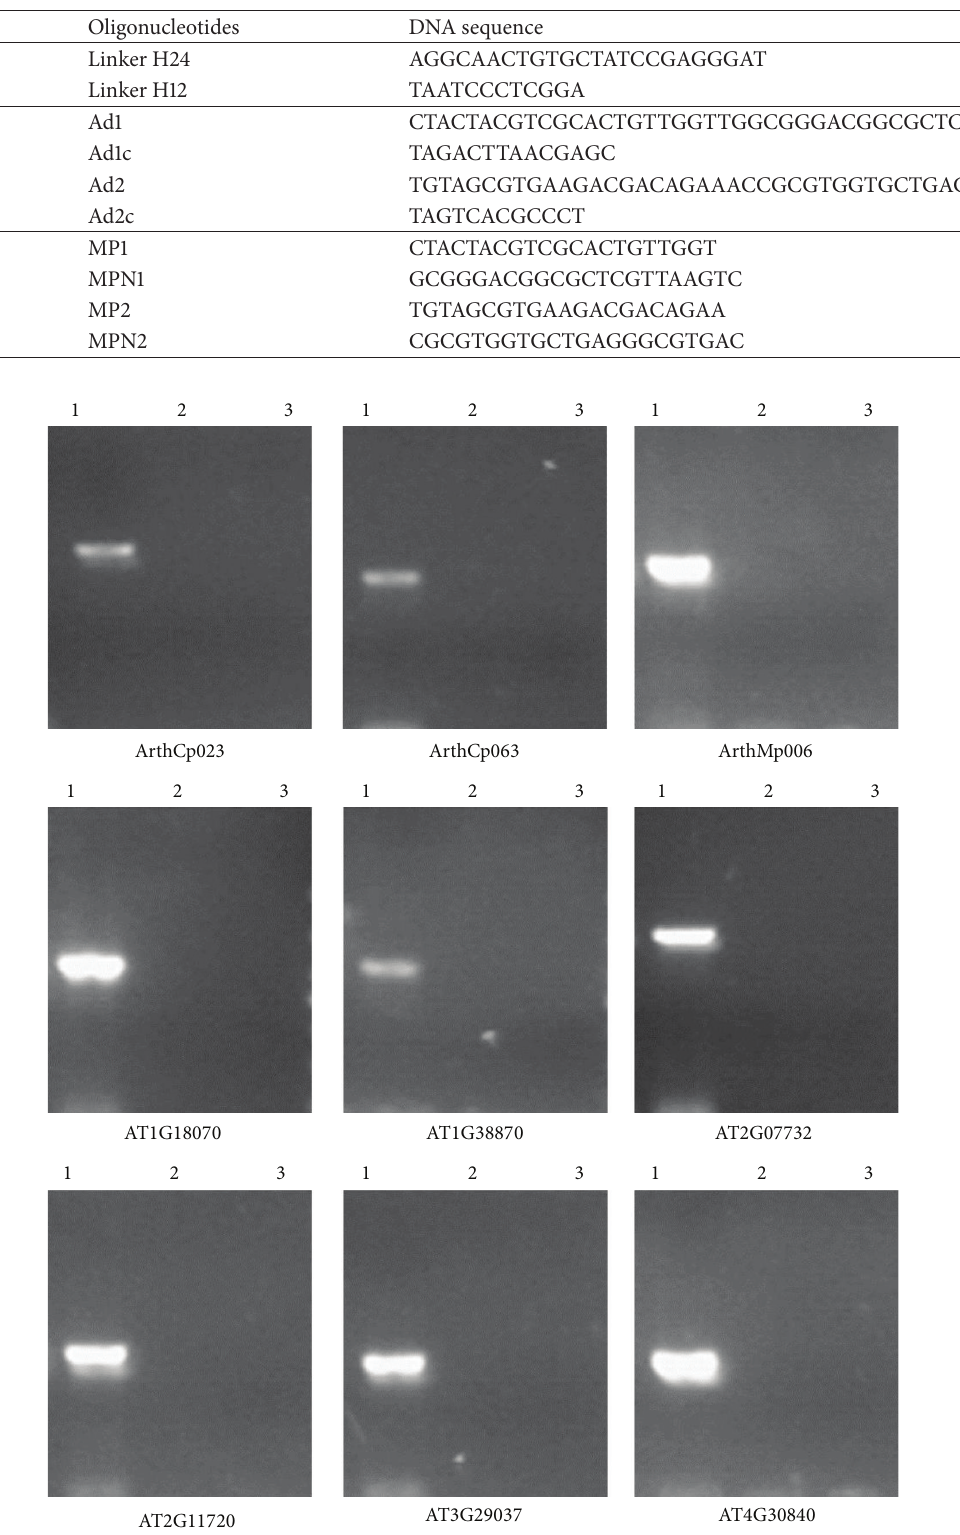
Table 1: Linkers, adapters, and primers used for SSH.